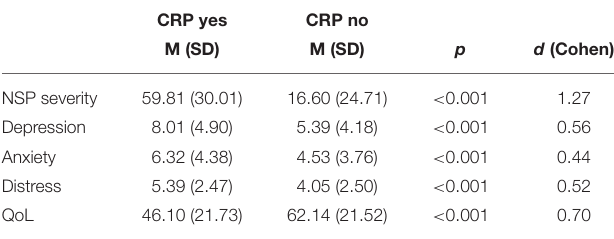
TABLE 2 | CRP prevalence and psychological